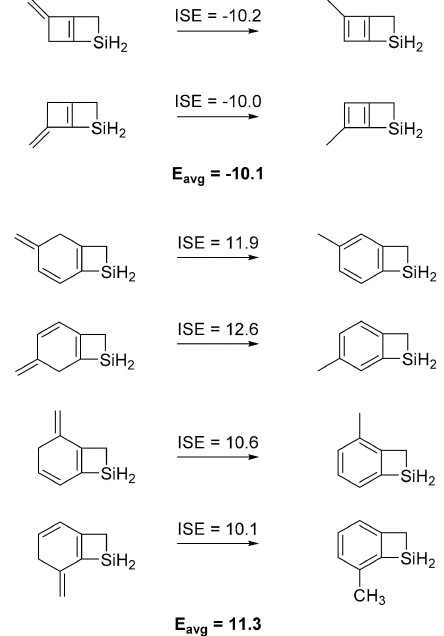
Figure 8. Isomerization stabilization energy (ISE) values (kcal/mol) of the 4- and 5-methyl substituted 1a ( T 1 ) derivatives, and the 5-, 6-, 7-, and 8-methyl substituted 2a ( T 1 ) derivatives at the UB3LYP/6-311G(d,p) level. ISE avg is the average ISE value for the various methyl